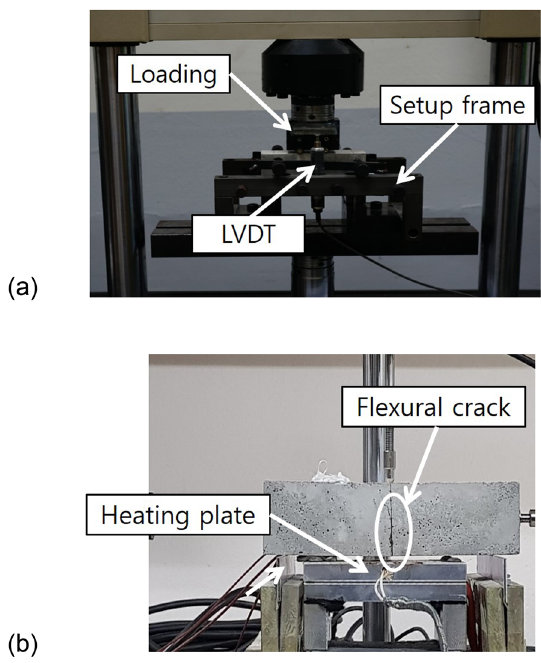
Figure 3: Experimental setup: ( a ) beam test and ( b ) crack - closing